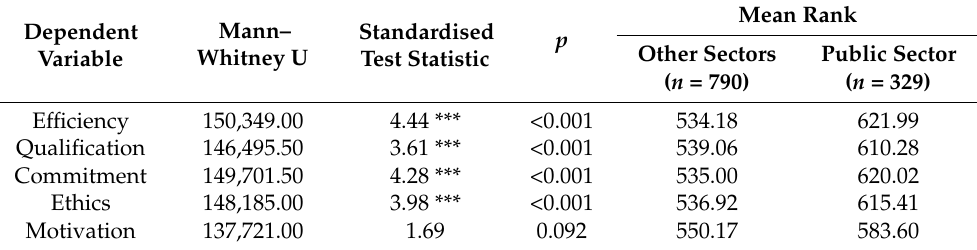
Table 6. Effect of activity sector on the perception of skills and attitudes of civil service employees.